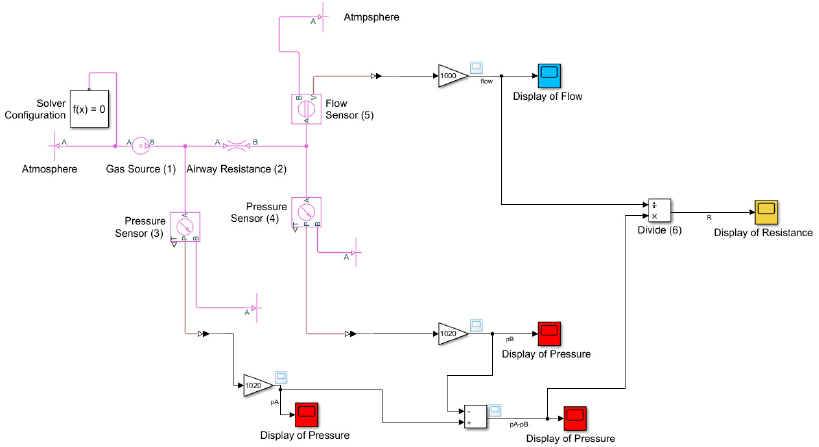
Figure A1. Airway resistance simulation code.